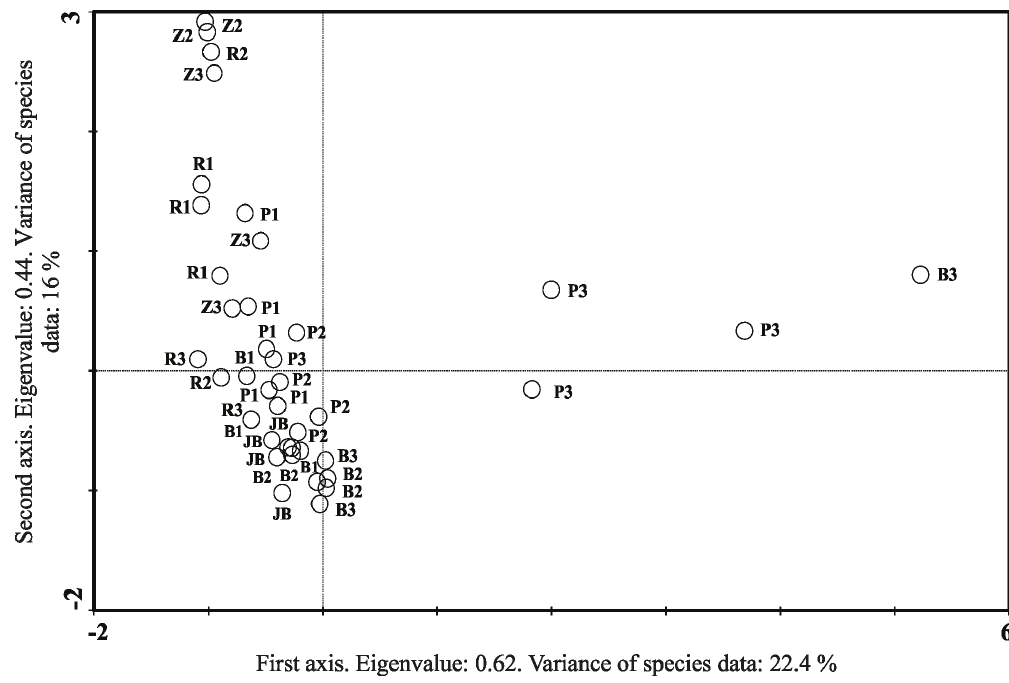
Figure 2. Correspondence analysis. Scatter plot of samples sites in pampean streams, Buenos Aires province, Argentina. R1-R3: Rodríguez, P1-P3: Pescado, Z2 and Z3: Zapata, B1-B3: Buñirigo, JB: Juan